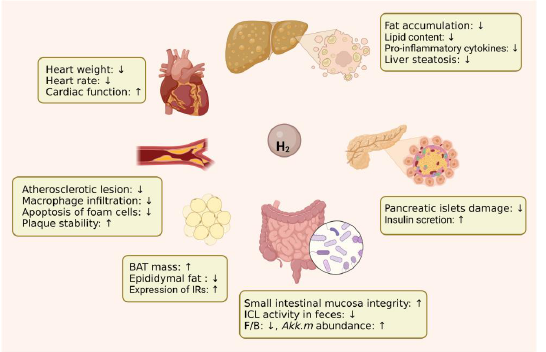
Figure 2. The main effects of H 2 on various tissues in metabolic diseases. Abbreviations: BAT, brown adipose tissue; IRs: insulin receptors; ICL: isocitrate lyase; F/B, Firmicutes / Bacteroidetes ; Akk.m , Akkermansia muciniphila .